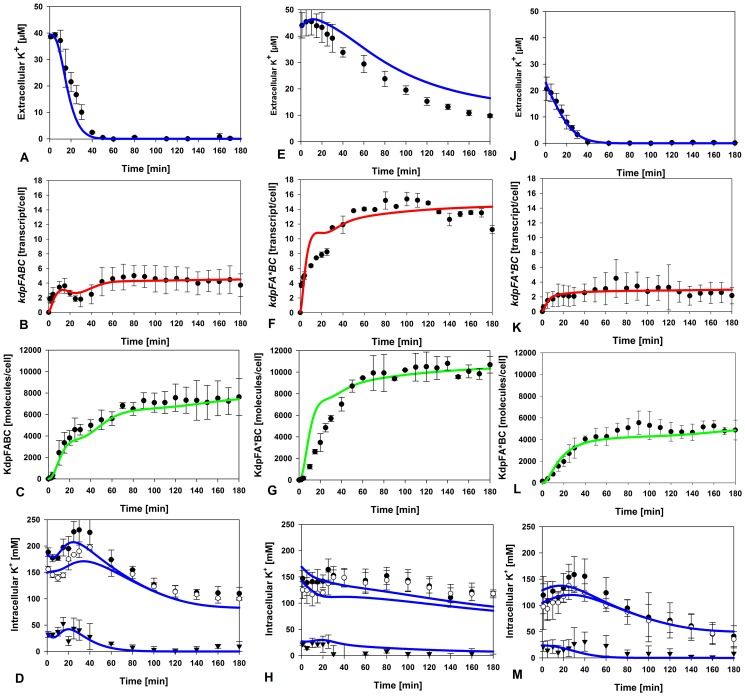
Induction kinetics of the Kdp system in E. coli.Exponentially growing cells were shifted to limiting K+ (40 µM K+) at time 0. At the indicated times thereafter cells were harvested, and extracellular and intracellular K+ concentrations were determined by atomic absorption spectroscopy, kdpFABC expression was measured by qRT-PCR, and KdpFABC production by quantitative Western blot analysis. Three different strains were used: MG1655 (A–D), RH010, which expresses KdpFA(G345S)BC and is defective in K+ transport (E–H), and RH010 transformed with plasmid pKT84, which encodes the high-affinity K+ transport system KtrAB (J–M). (A, E, J) Extracellular K+ concentration; (B, F, K) kdpFABC transcripts; (C,G,L) KdpFABC proteins; (D, H, M). Intracellular K+ concentrations: K+
total (•), K+
bound (○), K+
bound, and K+
free (▾). Results of simulations based on the model are presented by the coloured lines: K+ concentrations (blue), transcripts (red), KdpFABC proteins (green). All experimental data are average values of at least three independent experiments, and error bars represent the standard deviation of the mean.